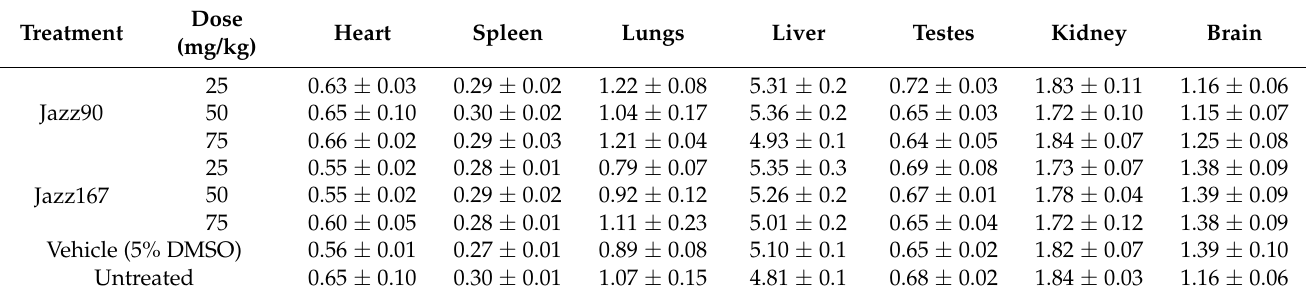
Table 1. Organ weight (% of body weight) of male BALB/c mice following Jazz90 or Jazz167 treatment.